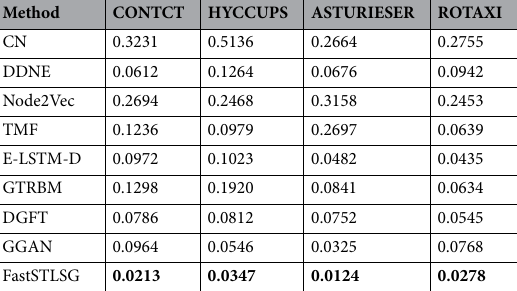
Table 8. Performances on NER for different methods. Significant values are in